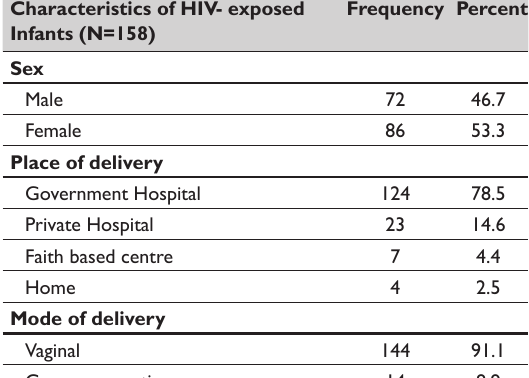
Table I. Selected Characteristics of 158 Infants of HIV Positive Mothers Seen at Ekiti State University Teaching Hospital (EkSUTH), Nigeria Characteristics of HIV- exposed Infants